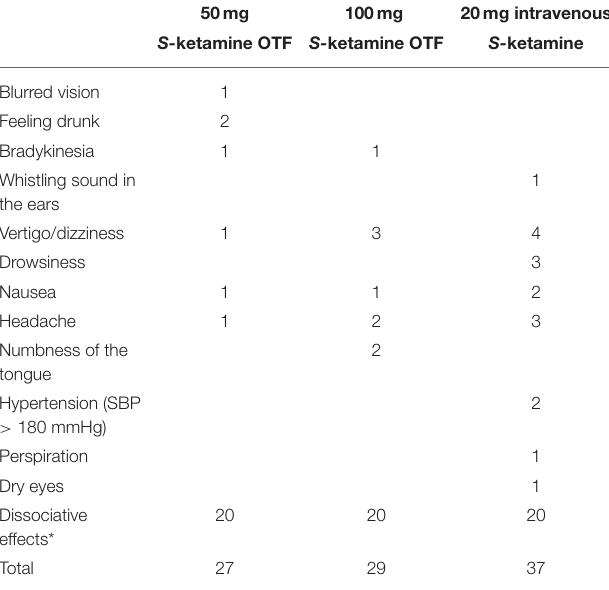
TABLE 3 | Adverse